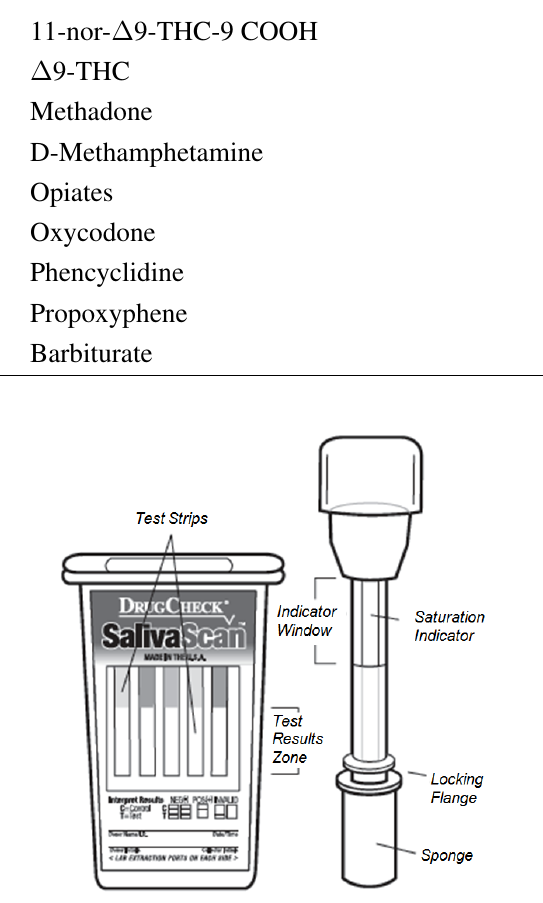
Figure 3. DrugCheck SalivaScan test. During the test procedure, the collection swab ( right ) will be inserted into the screening device ( left